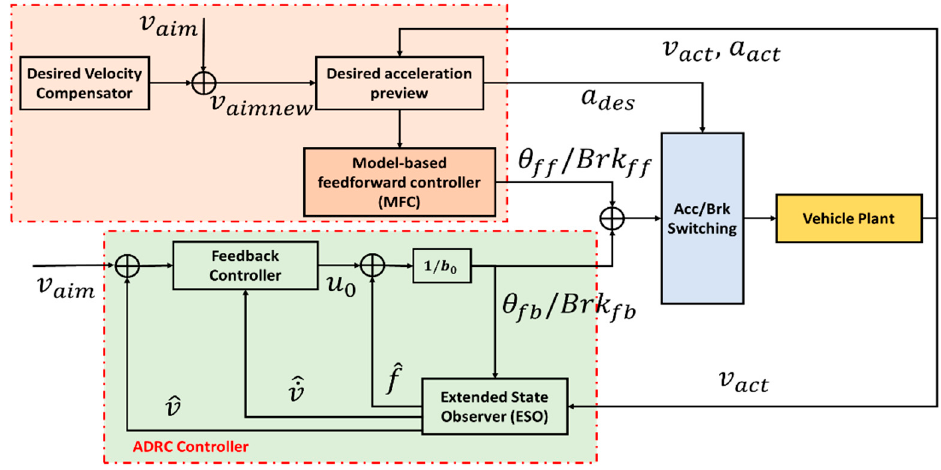
Figure 3. Block diagram of the longitudinal control algorithm.